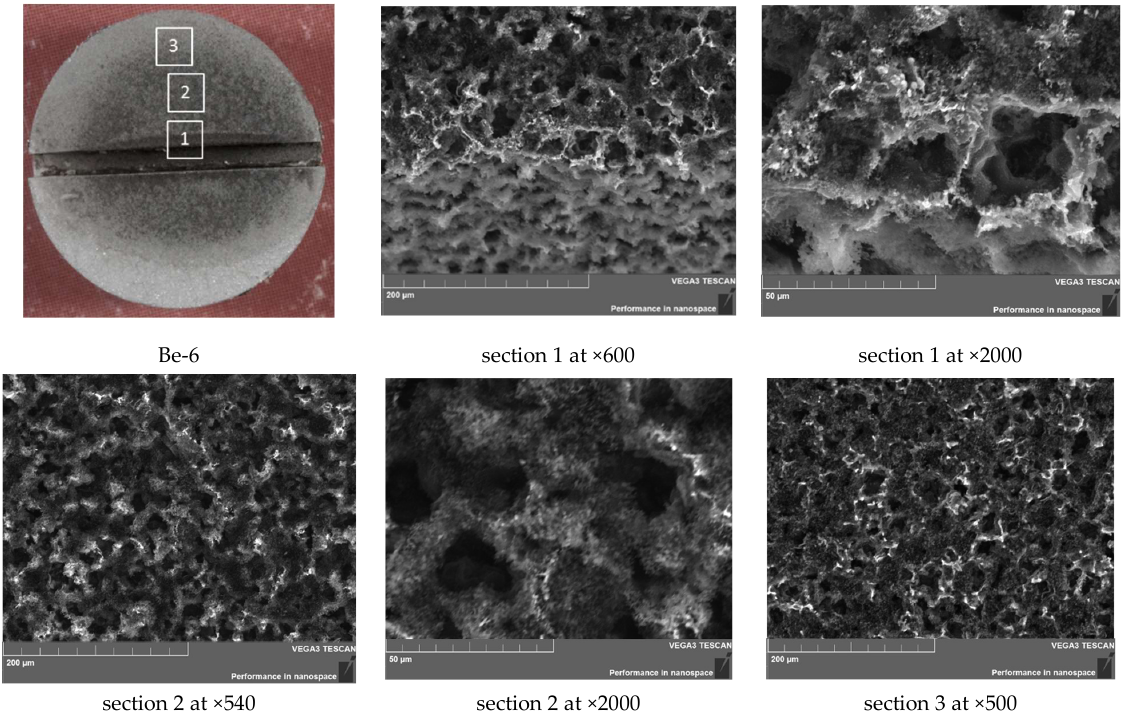
Figure 15. SEM images of the Be-3 sample surface (1200 °С, 100 cycles). The highest temperature and the most aggressive region of plasma–beam discharge action is located near the slot; this is because there is no heat removal through the side walls of the samples to the holder, and the plasma is maximally concentrated. As can be seen from the SEM images, off-center areas 2 and 3 are similar and less damaging than in area 1. 4. Conclusions Thus, in this research, experimental material studies were carried out concerning the impact of hydrogen plasma on TGP-56 type beryllium; as a candidate material for the first wall in the main ITER chamber facing the plasma. During irradiation, the number of pulses changed from 10 to 100 with the same duration of 500 s under the surface temper- atures of ~360 °C, ~800 °C, and ~1200 °C. Experimental data are obtained on the change in the surface morphology of beryl- lium as a result of irradiation. It is established that the change in roughness has an almost direct linear dependence, both on the increase in temperature and on the number of cycles. There is almost no change in the mass of samples irradiated at temperatures of ~360 °C and ~800 °C; this positively characterizes the test material. The main mass change oc- curs in samples irradiated at ~1200 °C, which is associated with large-scale surface erosion and material evaporation.